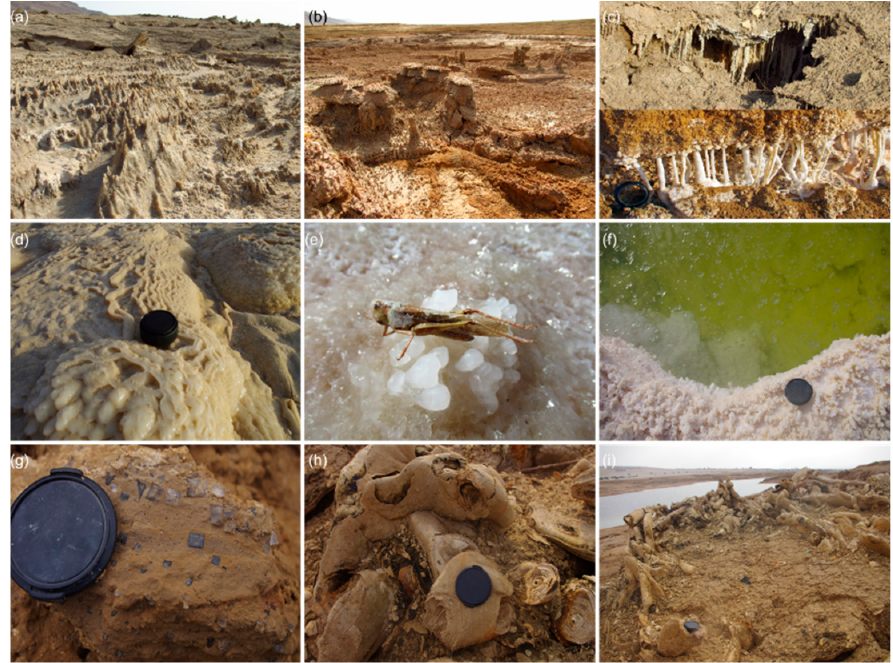
Figure 11. Forms and structures of evaporite minerals found at the UGGp highlight area: ( a – c ) calcite stalagmites and stalactites in the salt ‐ mudflat, ( d – f ) recent halite near the shoreline, ( g ) idiomorphic halite crystals in mud, ( h–i ) aragonite structures at the mudflat. All photos were taken by Djamil Al ‐ Halbouni.